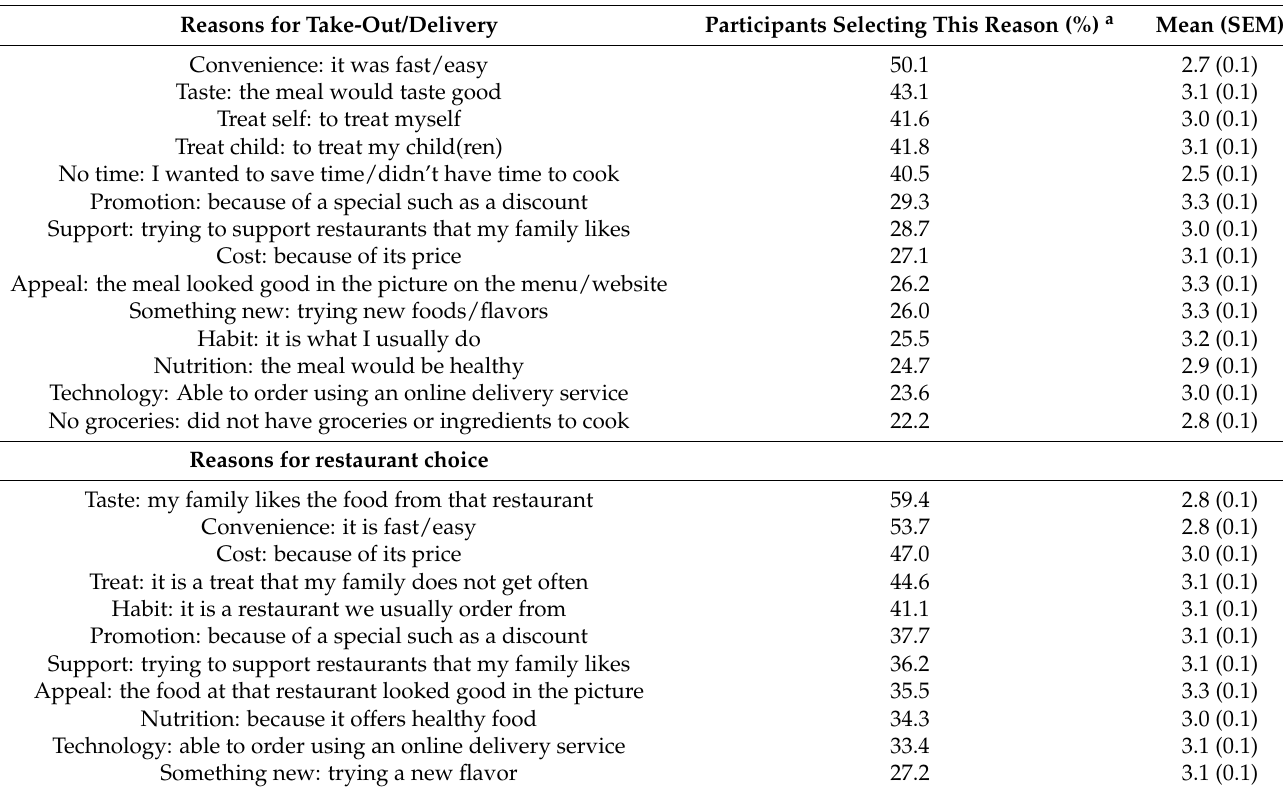
Table 7. Reasons behind parents’ take-out and delivery orders over the past 2